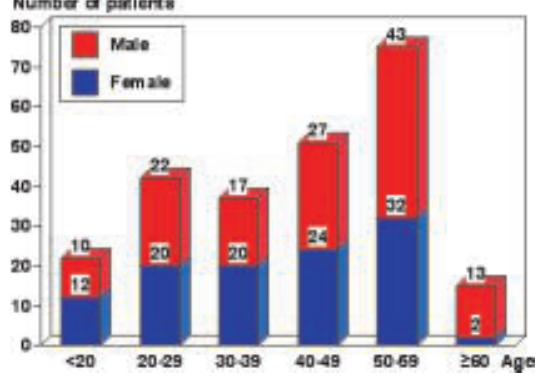
trypsin deficiency and 2 with non-transplant oblit- erative bronchiolitis, followed by parenchymal dis- orders (n = 47), pulmonary hypertension (n = 26) and lymphangioleiomyomatosis (n = 6). There were only 8 retransplantations. Both lungs were transplanted in 188 and single lungs in 54